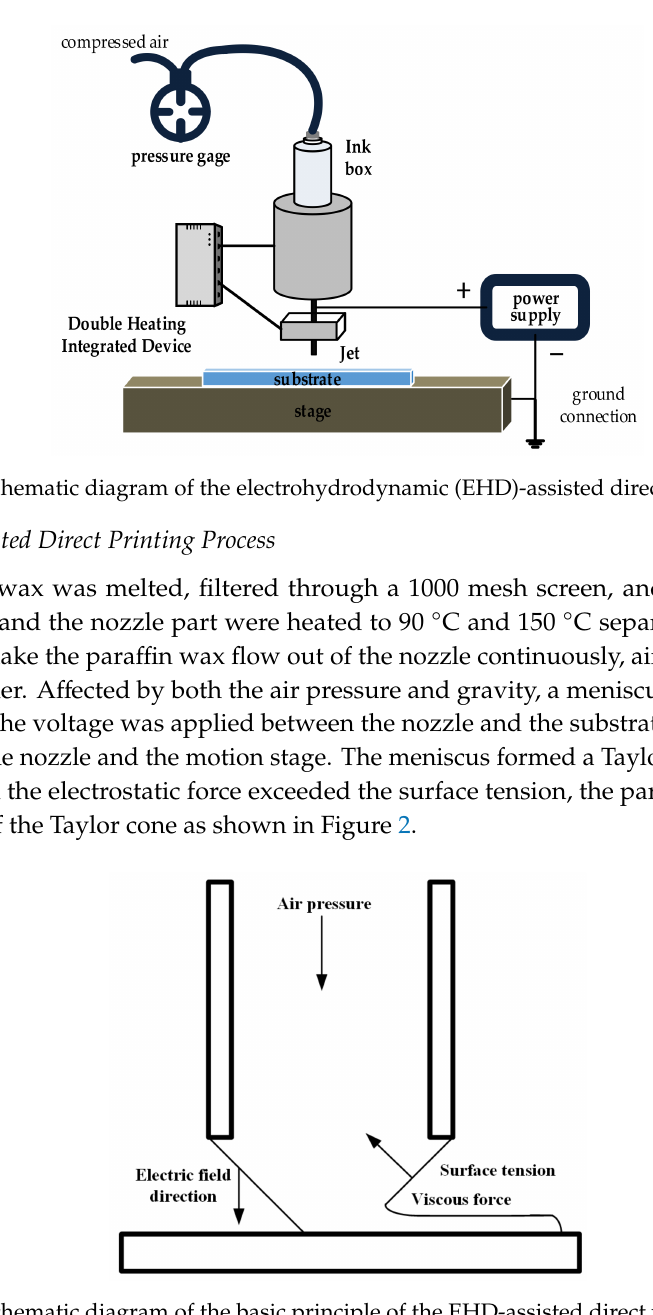
Figure 2. Schematic diagram of the basic principle of the EHD-assisted direct printing